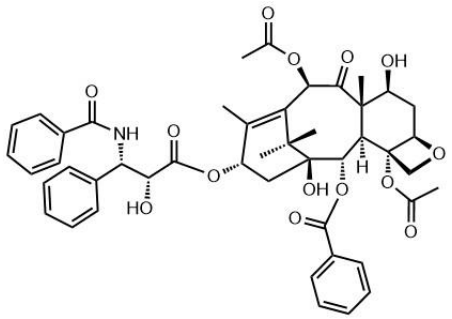
Figure 1. Chemical structure of paclitaxel/taxol.